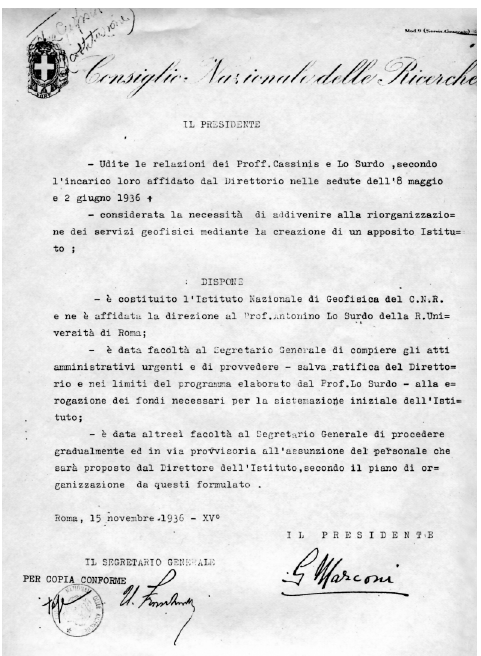
Fig. 1. Resolution establishing the Istituto Nazionale di Geofisica (Nov. 15,